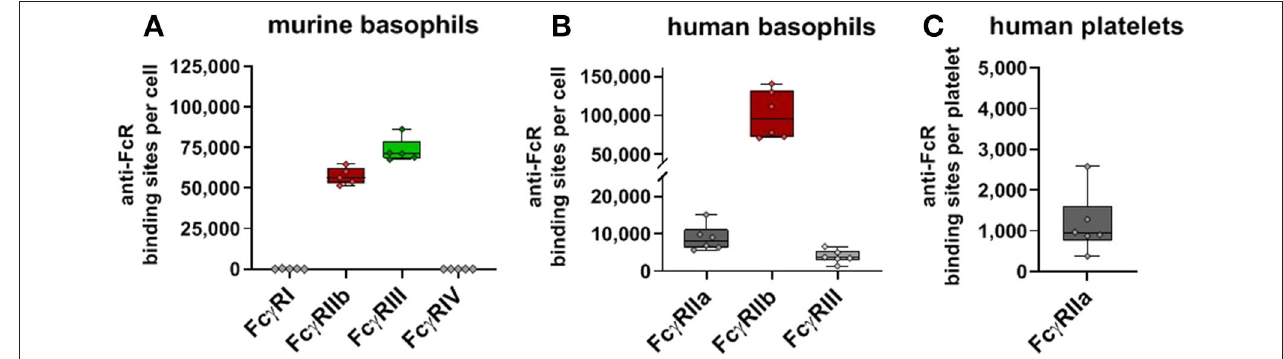
FIGURE 6 | Fc gamma receptors on basophils and platelets. Depicted are box plots showing anti-Fc γ R binding sites for receptors expressed on (A) murine or (B) human basophils, and (C) human platelets from five C57BL/6 mice or six human donors,